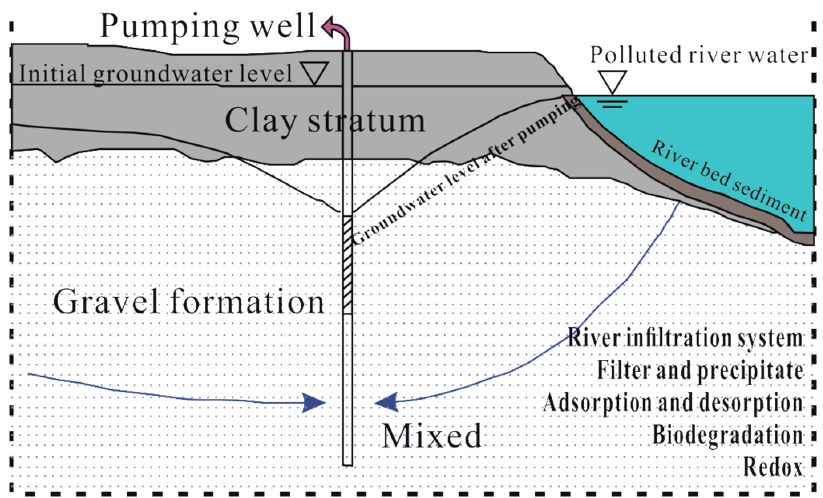
Figure 1. Schematic diagram of the migration and transformation of pollutants in a river infiltration system.